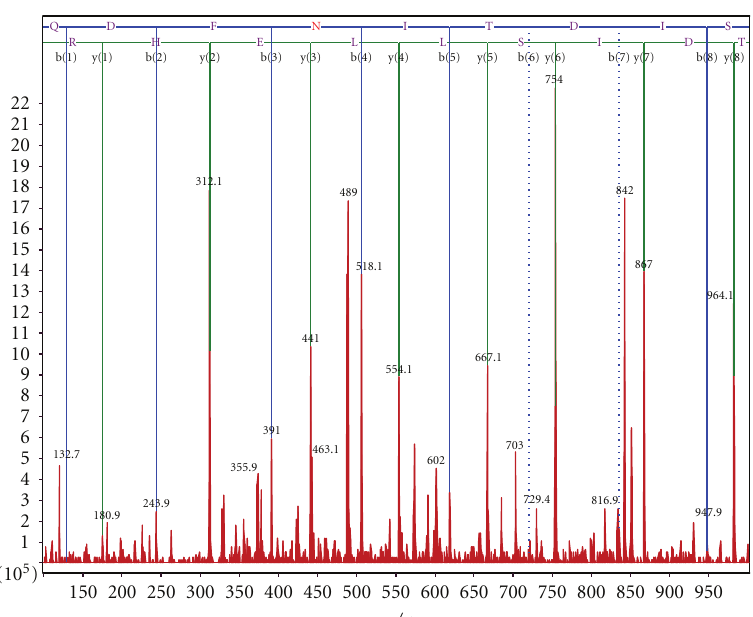
Figure 7: MS/MS spectrum of the deglycosylated peptide QDF N ITDISLLEHR. N represents the Asp residue formed via PNGase F deglycosylation from the glycosylation site at the Asn